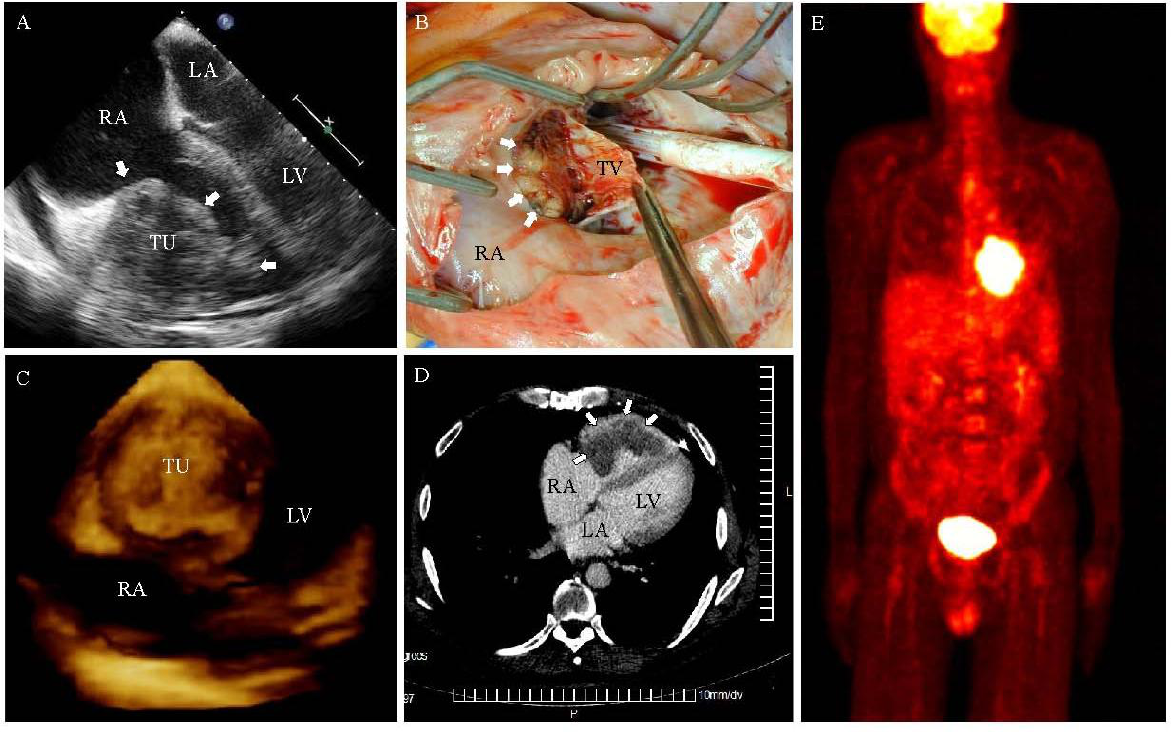
FIGURE 1. (A) TEE revealed a large tumor (arrowed) of the RV cavity (7  5 cm in size) without impairing the tricuspid valve. (B) Intraoperative imaging of the prolapsed mass (arrowed) confirmed tumor extension to the basis of the tricuspid valve. (C) 3-D TTE visualized an almost completely filled RV by the cardiac tumor. (D) Contrast-enhanced CT determined a renewed contrast agent–sparing tumor (arrowed) located in the RV. (E) Total body PET substantiated high-glucose metabolism of the cardiac carcinoma relapse by intensive FDG-uptake into the tumor (hot metal staining). TU indicates tumor, RA indicates right atrium, LA indicates left atrium, LV indicates left ventricle. TV indicates tricuspidal